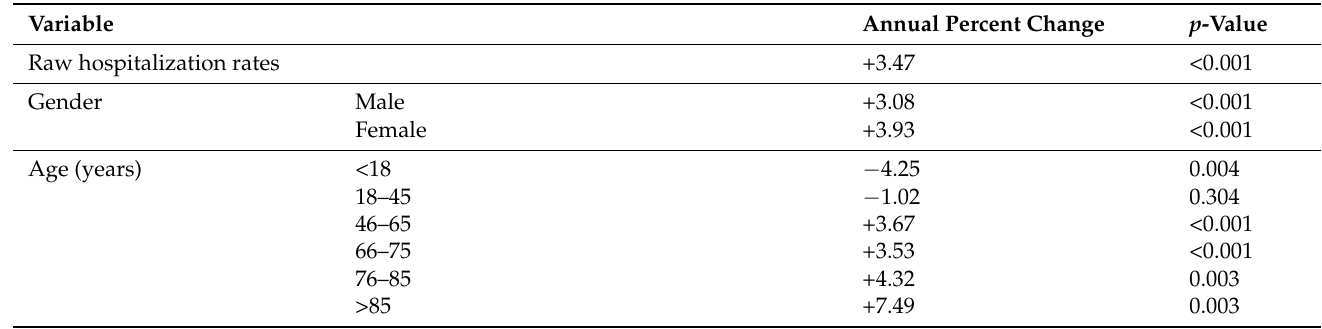
Table 4. Annual percent changes in hospitalization rates for pneumonia in Italy from 2010 to 2019 stratified by different